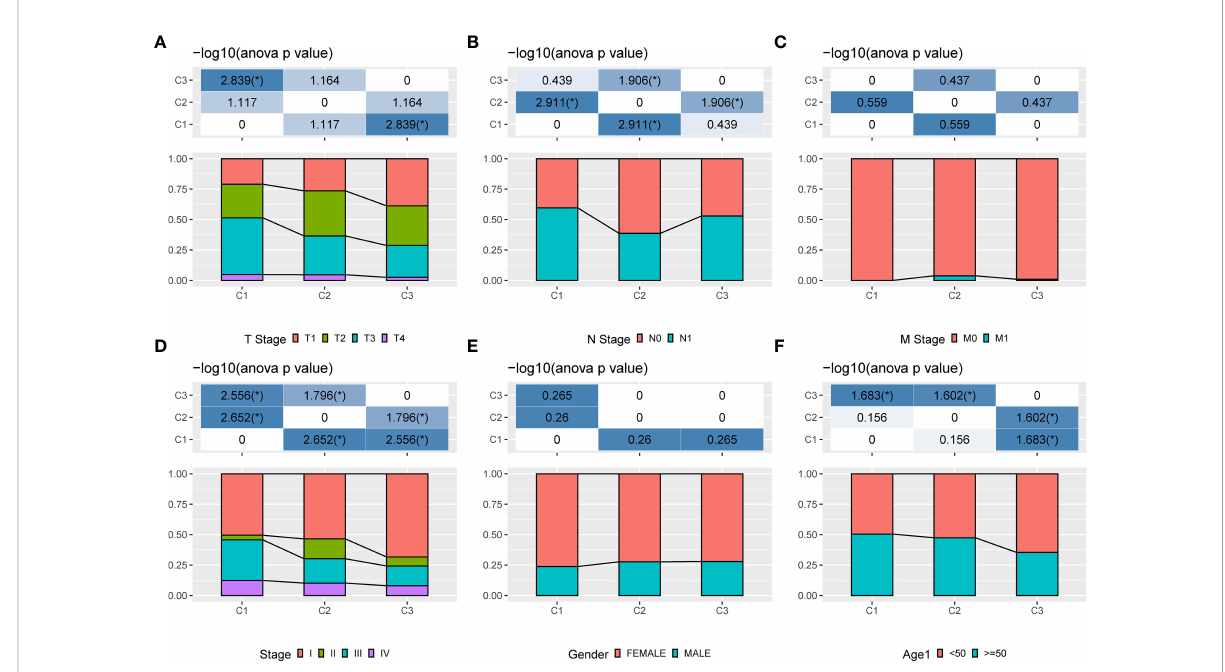
FIGURE 4 Clinical information of different molecular subtypes. (A) : T stage; (B) : N stage; (C) : M stage; (D) : Total stage; (E) : Gender; (F) :